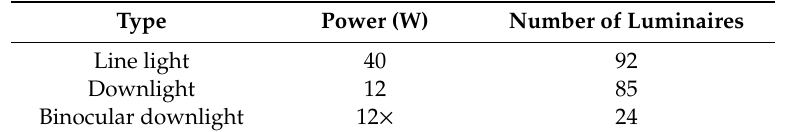
Table 6. Specifications of the luminaires in scenario 2.